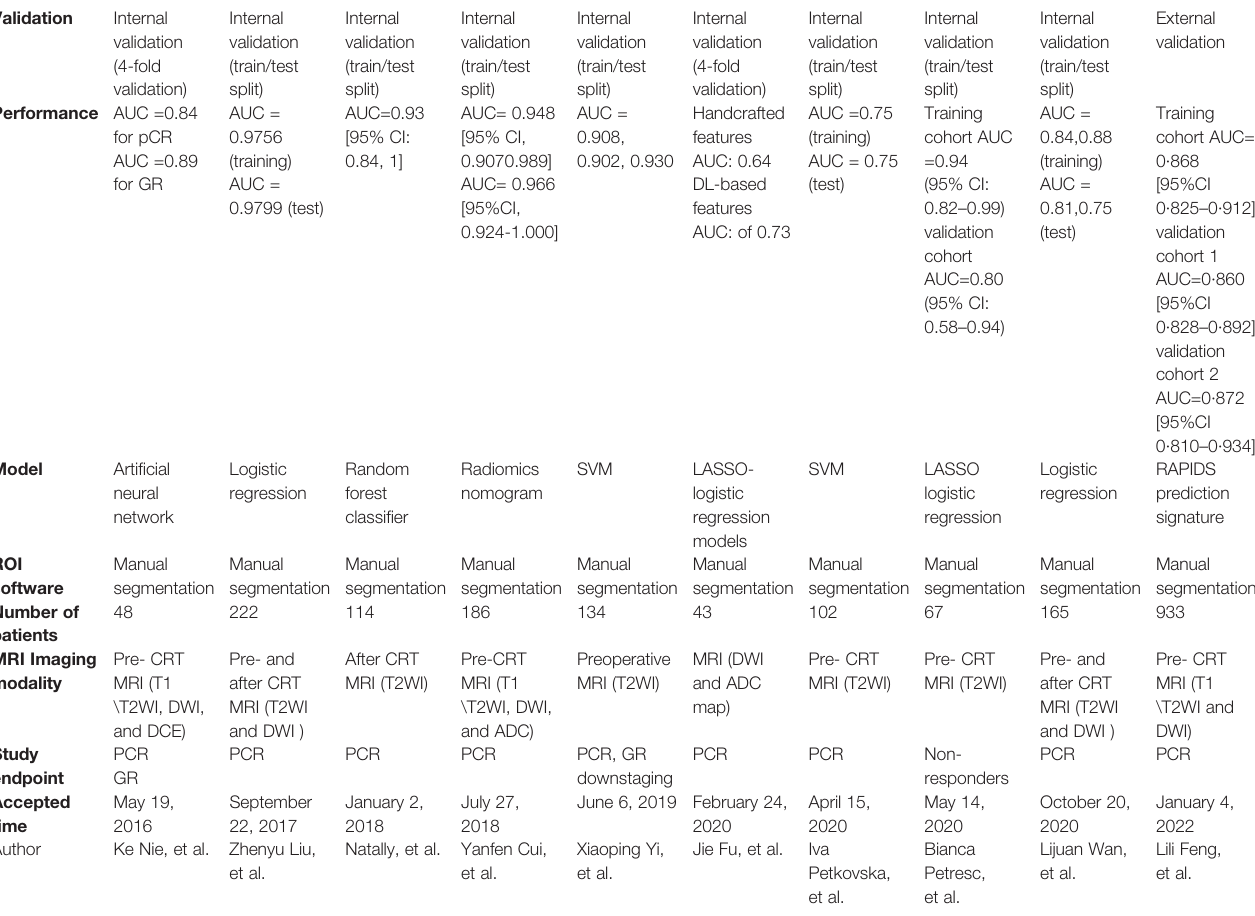
TABLE 2 | Summaries of selected LARC radiomics studies